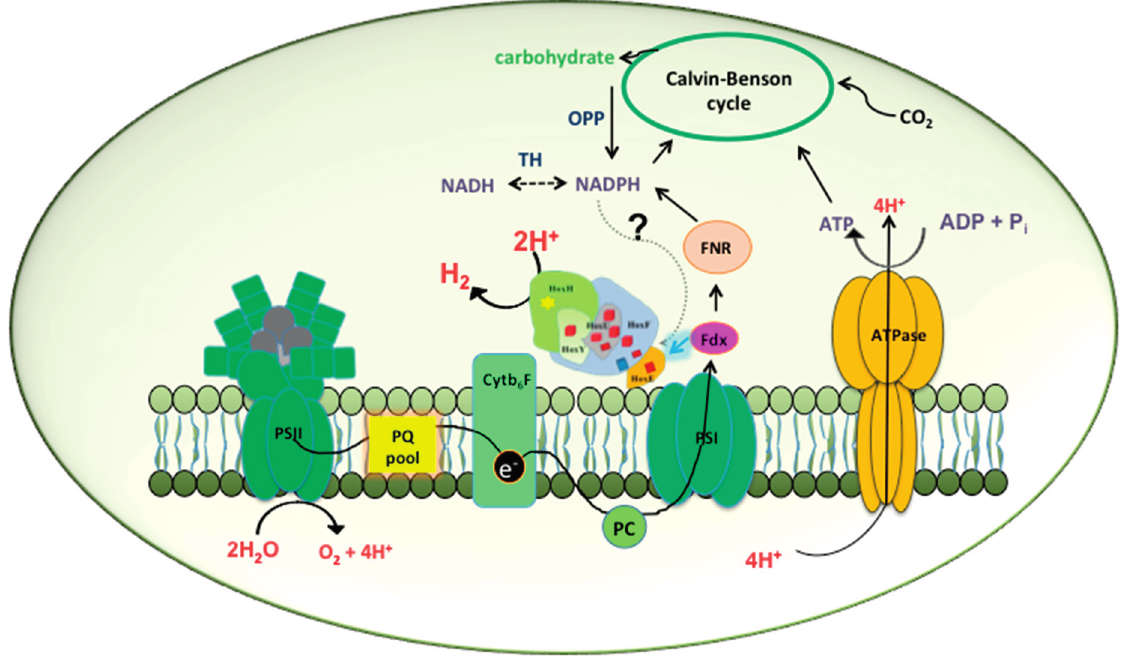
Figure 1. Biochemistry of hydrogen production in Synechocystis PCC 6803 by